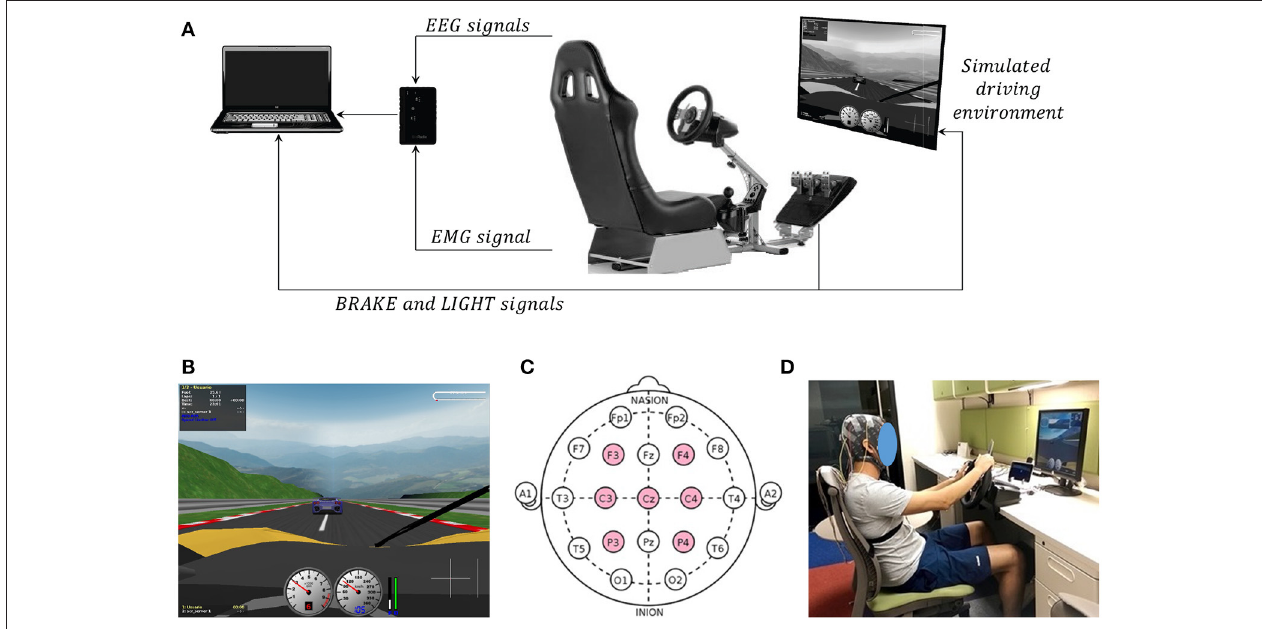
FIGURE 1 | (A) Illustration of the driving system and environment. The driving system consisted of a commercial set of pedals, steering wheel and gear lever for driving simulators, a 19 inches flat-screen and a computer to control the execution of the experiment. The driving environment consisted of an oval track and contained the participant’s vehicle and a guide vehicle. (B) Image of driving environment in a first person perspective as seen by the participants. (C) EEG electrode locations used in this experiment. (D) Snapshot of the experiment with a participant wearing the EEG electrodes (the participant gave written informed consent to publish this picture).